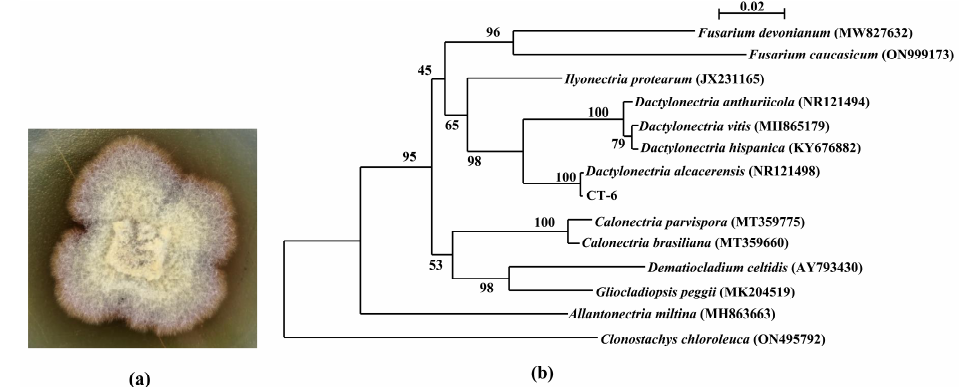
Figure 1. Colony of D. alcacerensis CT-6 ( a ) and phylogenetic tree of the endophyte CT-6 based on ITS region and 5.8S sequences ( b ). Bootstrap values greater than or equal to 50% (1000 replicates) are shown at branches.